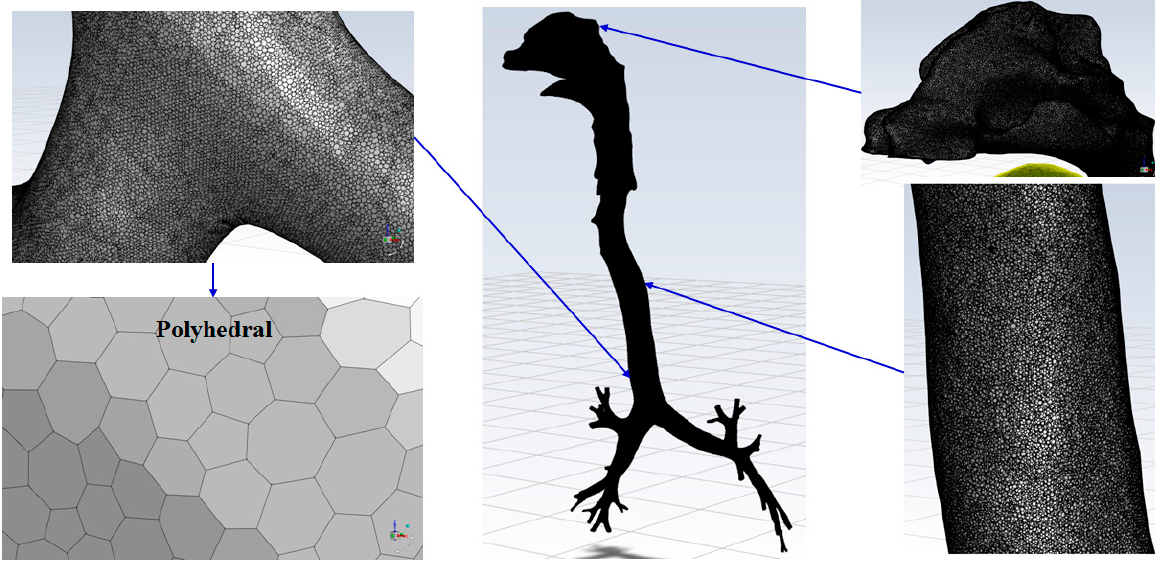
Figure 2. Numerical grid generation in human airways.